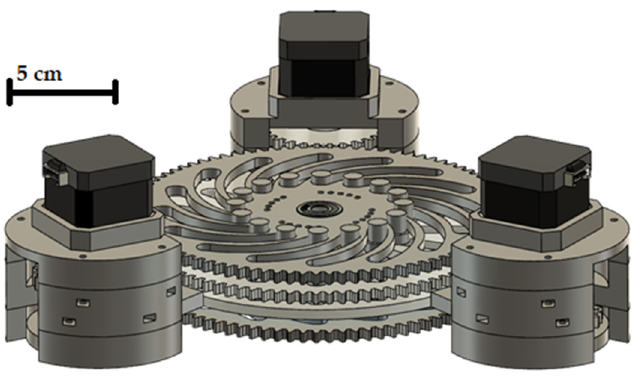
Figure 18. CAD drawing of the entire structure of both mechanisms with stepper motors.